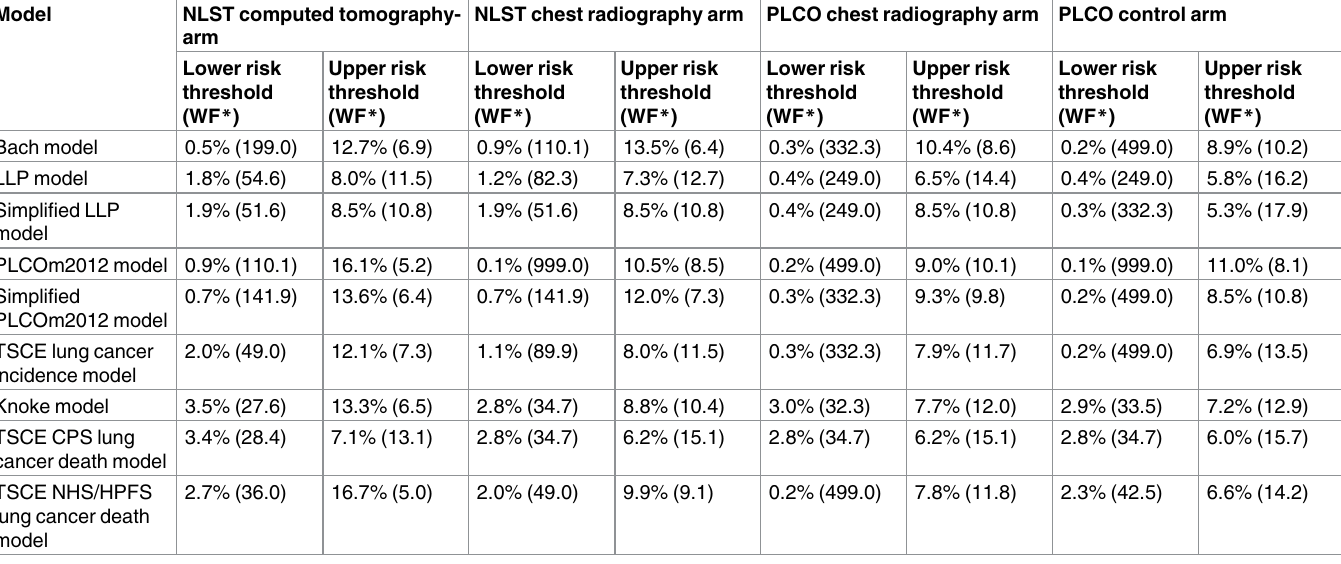
Table 3. Lower and upper risk thresholds for which the risk prediction models have a positive net benefit compared with the National Lung Screening Trial criteria for 6-y lung cancer incidence.